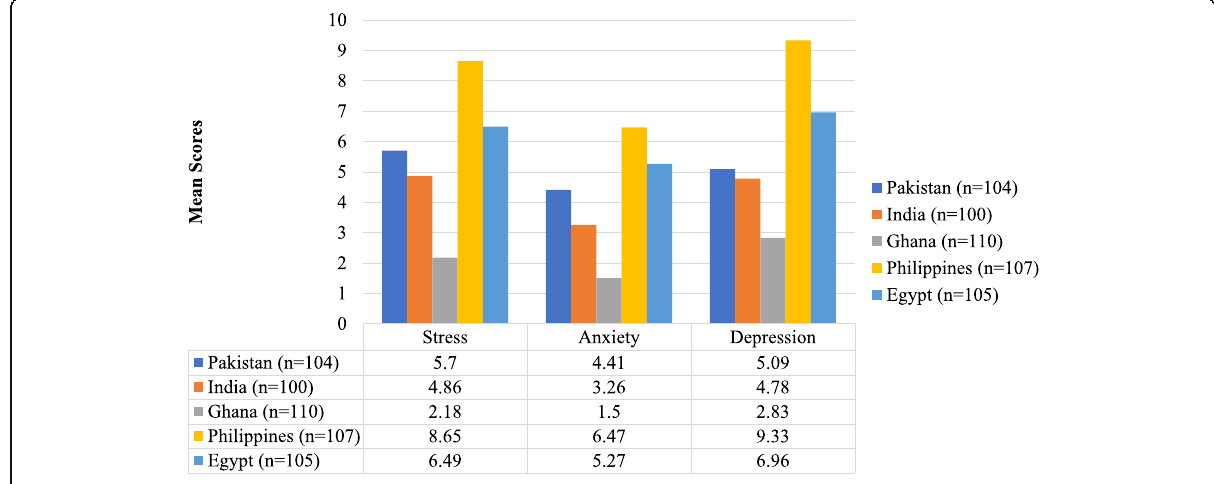
Fig. 1 Mean stress, anxiety, and depression score among countries